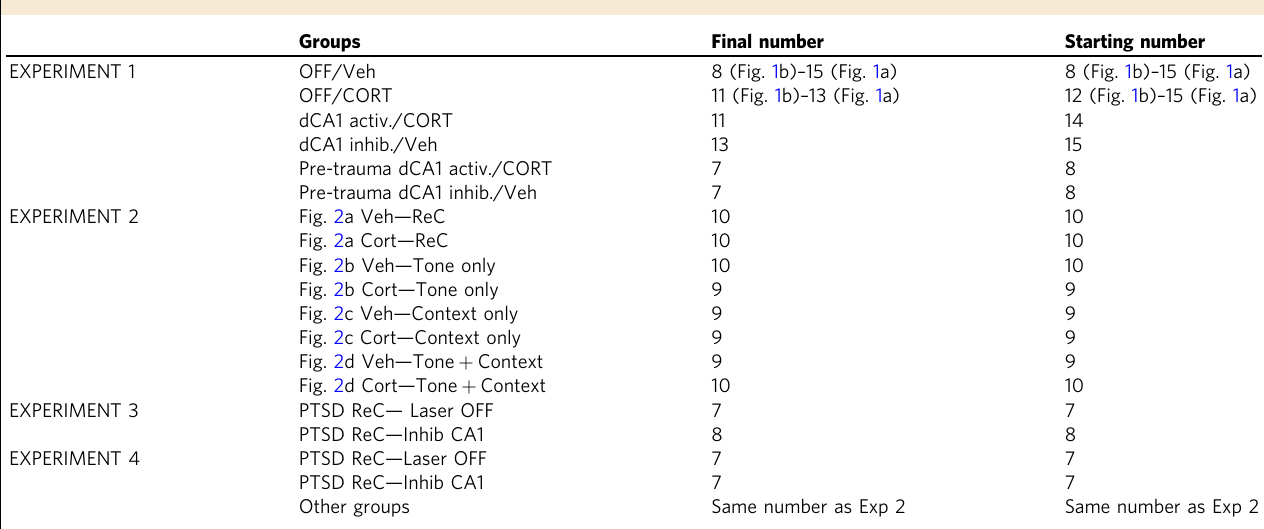
Table 1 Detailed number of mice in each experimental group.